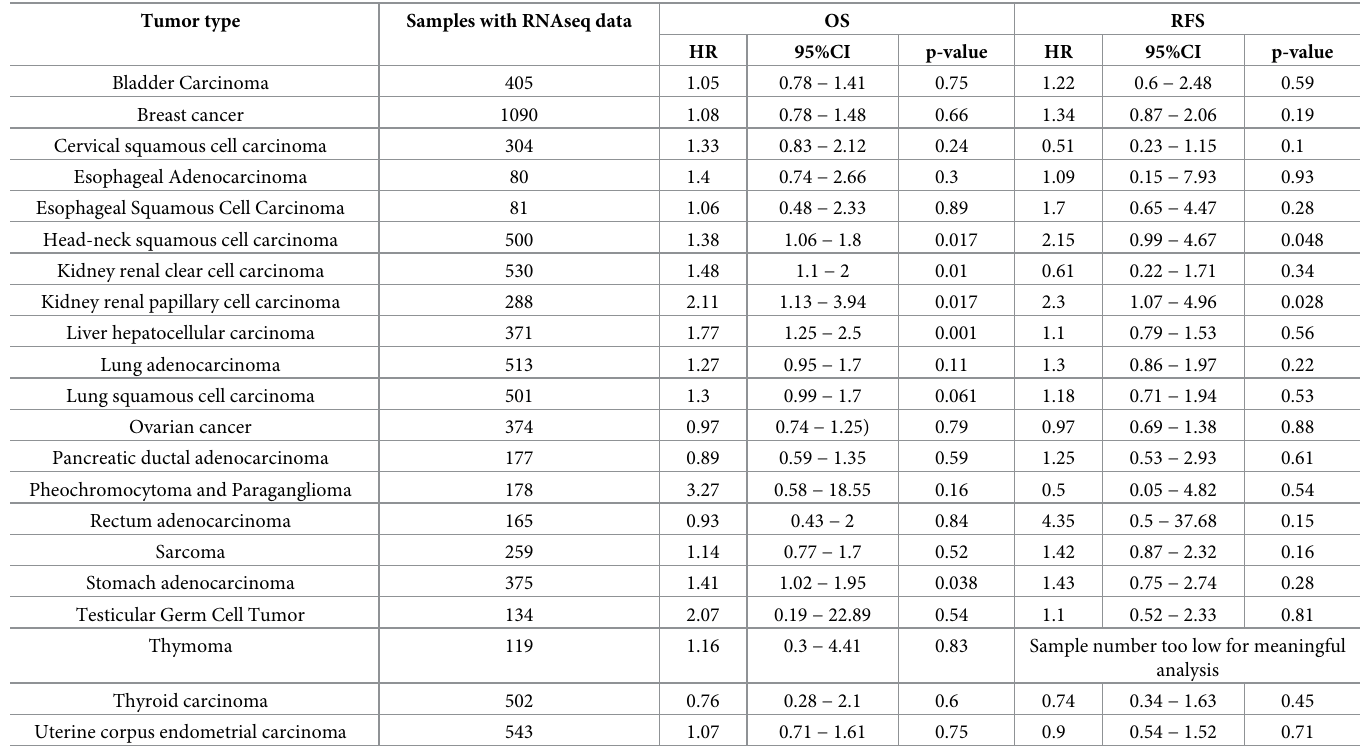
Table 1. Correlation of aromatase mRNA expression with overall (OS) and relapse-free survival (RFS) in various cancer